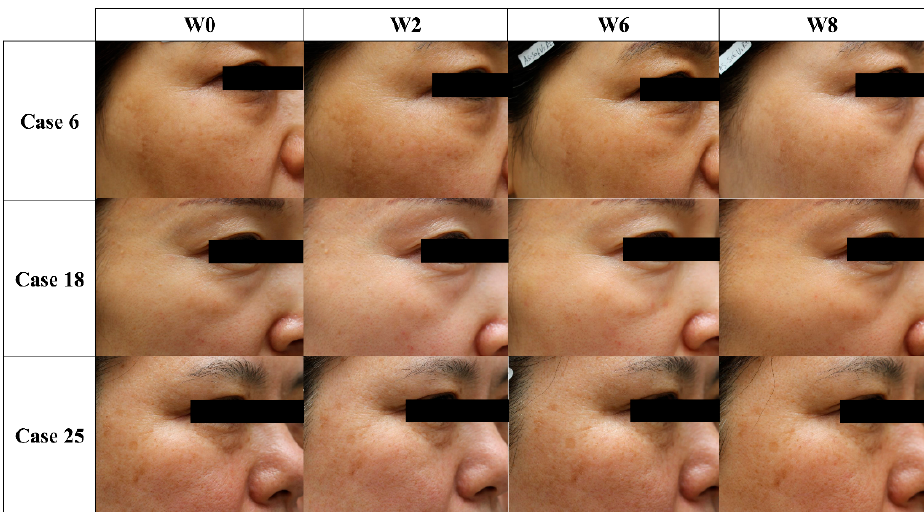
Figure 3. Clinical photographs of three representative cases at week 0, 2, 6, and 8 (W0, W2, W6, and W8). Note the improvements in the wrinkles of the lateral canthal lines and the skin textures after Agnes radiofrequency hydro-injector ® (Agnes Medical Co., Ltd., Gyeonggi-do, Korea) treatment.